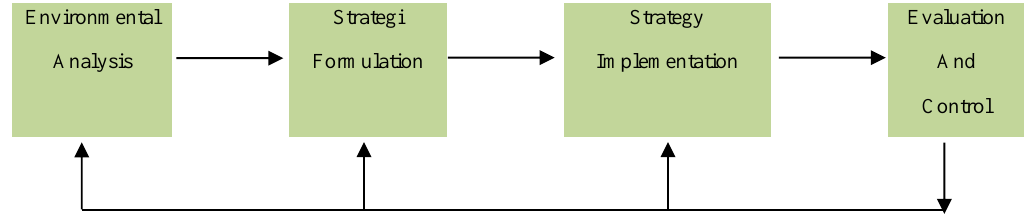
Figure 1: Basic Model of Strategic